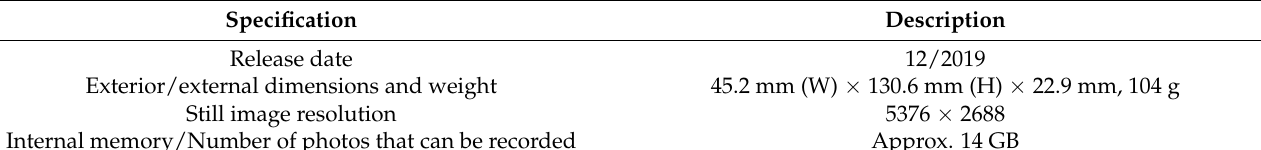
Table 2. Technical features of Ricoh Theta SC2.